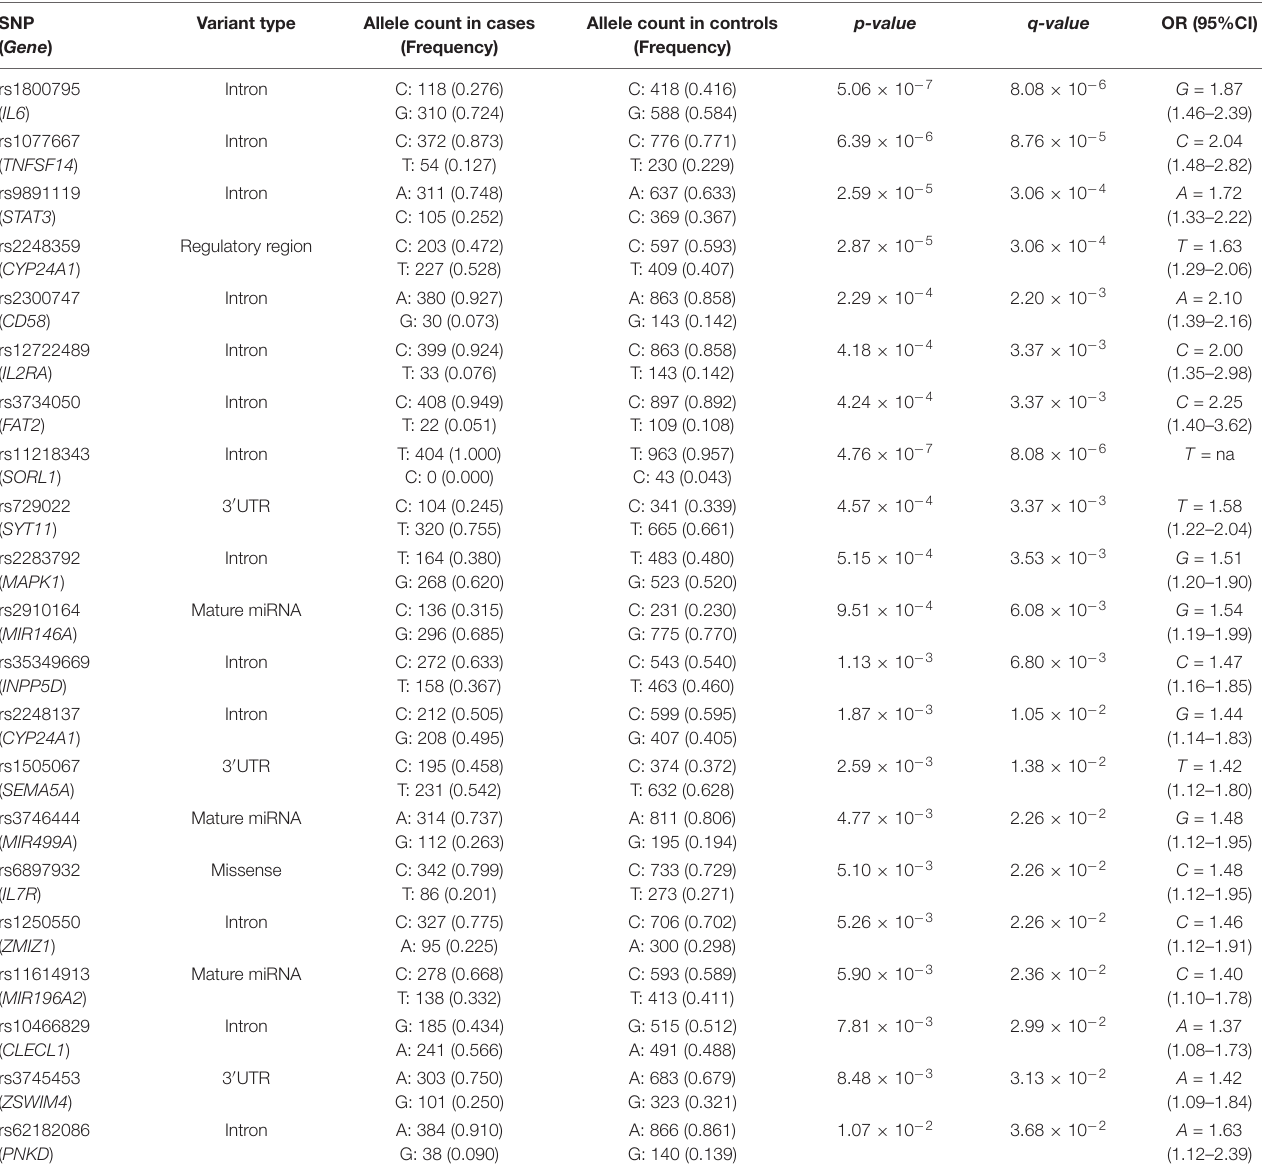
TABLE 2 | Genetic variants significantly associated with